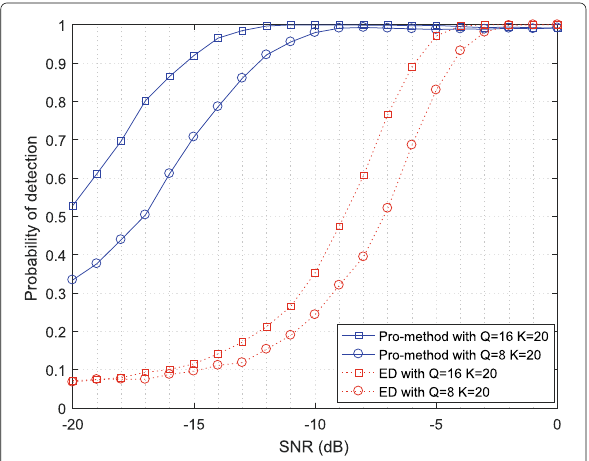
Fig. 4 Probability of detection versus SNR for the proposed method and ED with different sampling